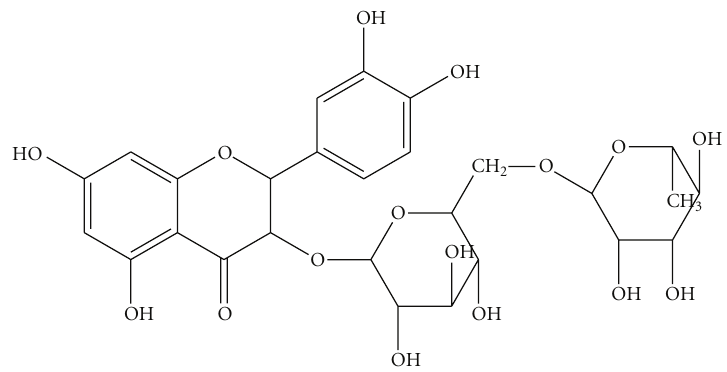
Figure 1: Rutin chemical